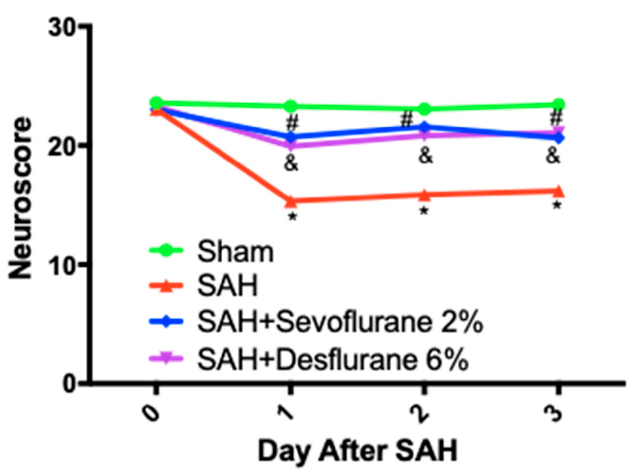
Figure 4. Sevoflurane and desflurane conditioning improves neurologic outcomes after SAH: mice were exposed to 2% sevoflurane, 6% desflurane, or room air for one hour, one hour after the SAH or sham surgery. Higher neuroscores indicate better neurological function. Day 0 neuroscores represent baseline status; mice were sacrificed on Day 3. A two-factor repeated-measures ANOVA and a post hoc Student–Newman–Keuls test were used to compare treatment groups: Sham vs. SAH + room air * ( p < 0.05), SAH + room air vs. SAH + Sevoflurane # ( p < 0.05), SAH + room air vs. SAH + Desflurane & ( p < 0.05).